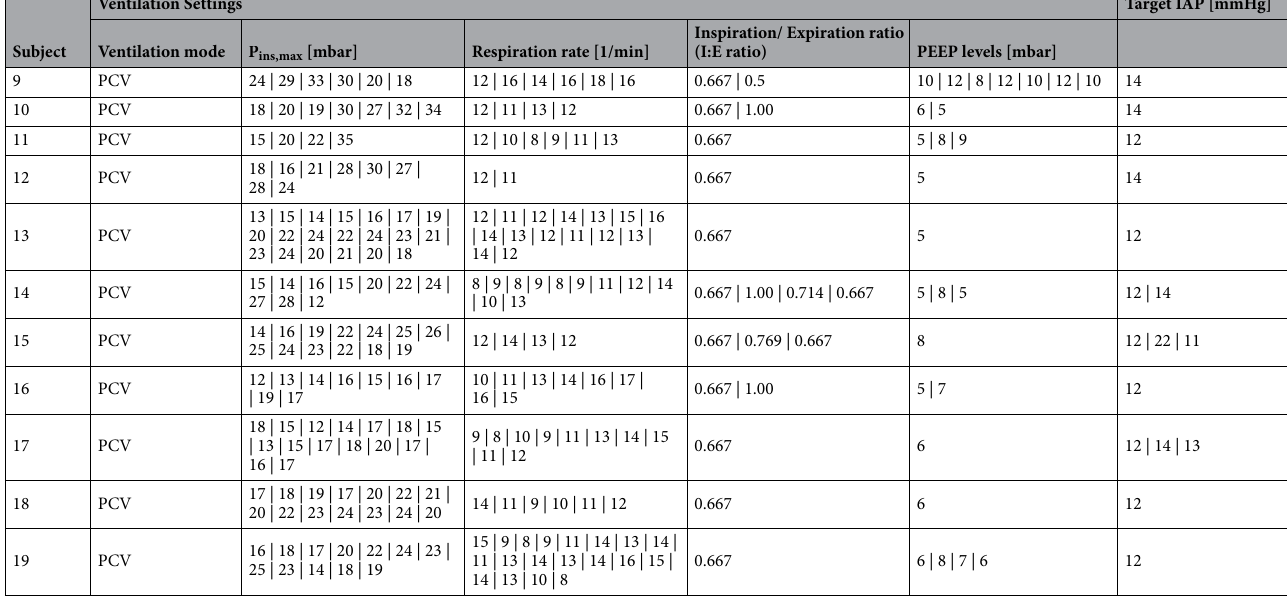
Table 6. Ventilation settings and target IAP for pressure-controlled ventilated patients. PCV refers to pressure-controlled ventilation mode. P ins , max refers to the pre-set inspiration pressure.